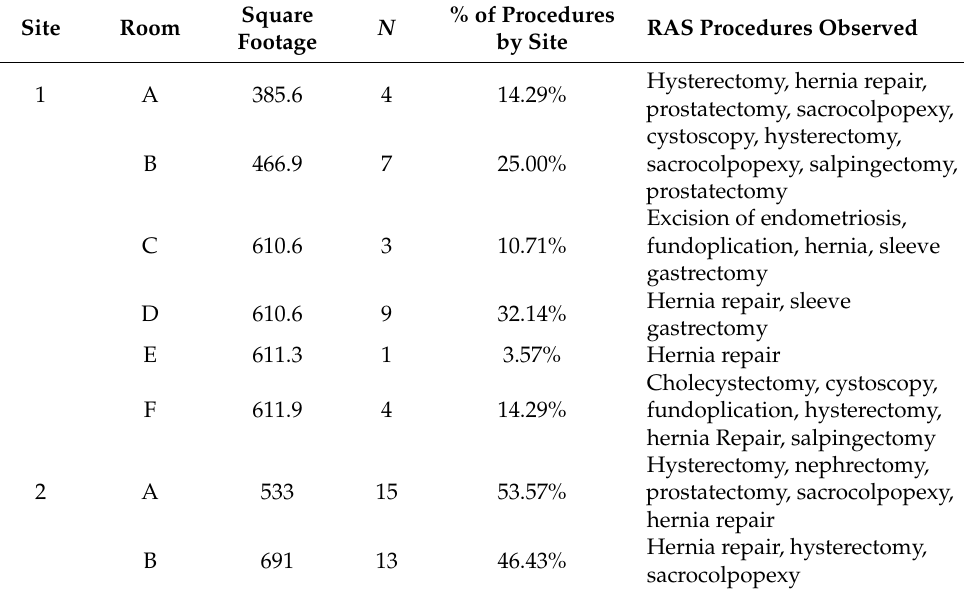
Table 1. Overview of room size and RAS procedures observed during this